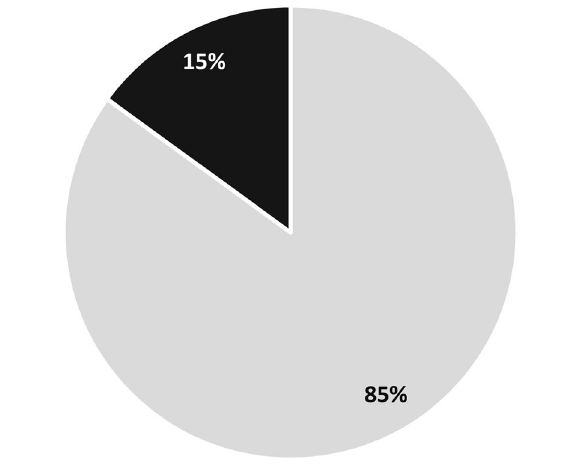
Fig. 6 Preference for Solar Energy by SMEs. Source: Researchers’ Questionnaires